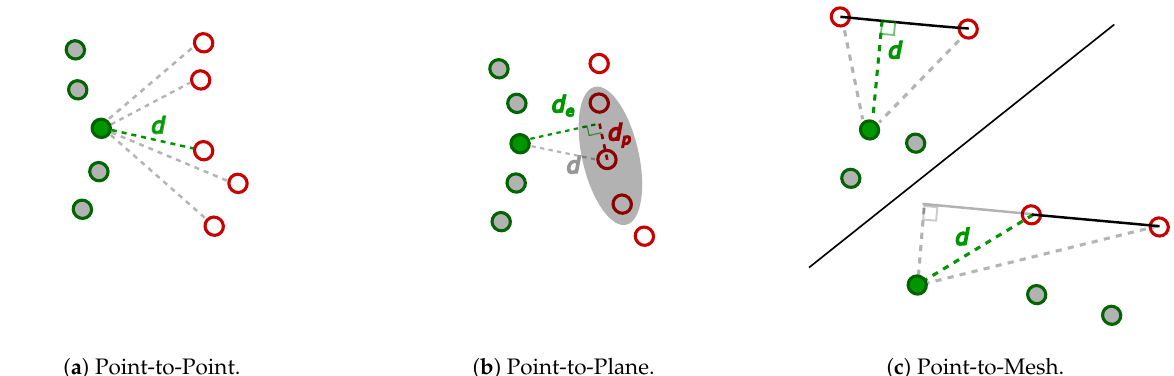
Figure 4. Three different types of point cloud comparison. Red markings signify the reference, while green and gray signify the measured